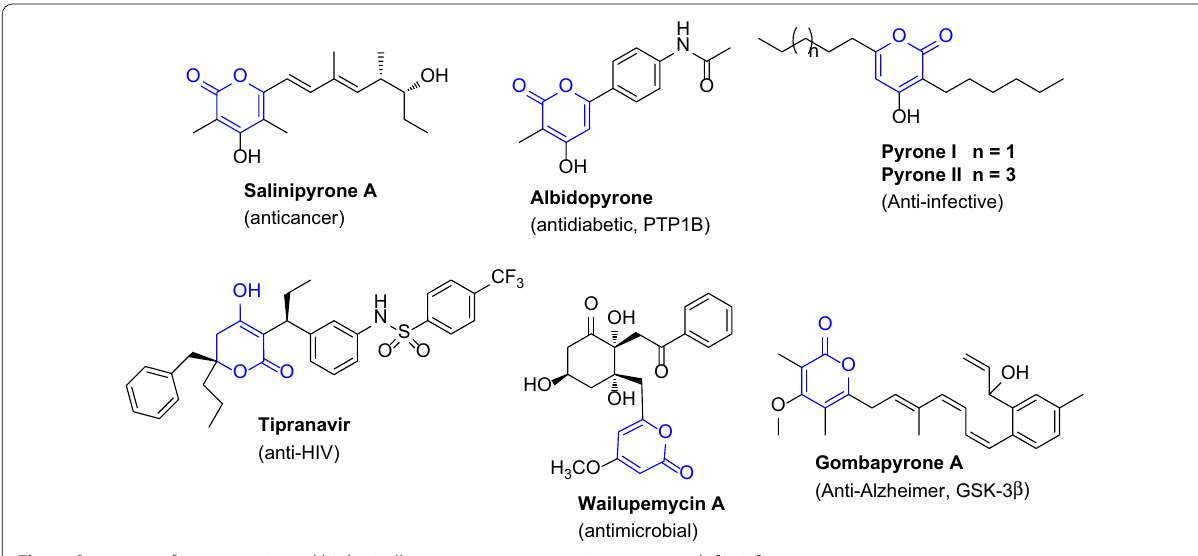
Fig. 1 Structures of some nominated biologically potent α-pyrone marine compounds [3,